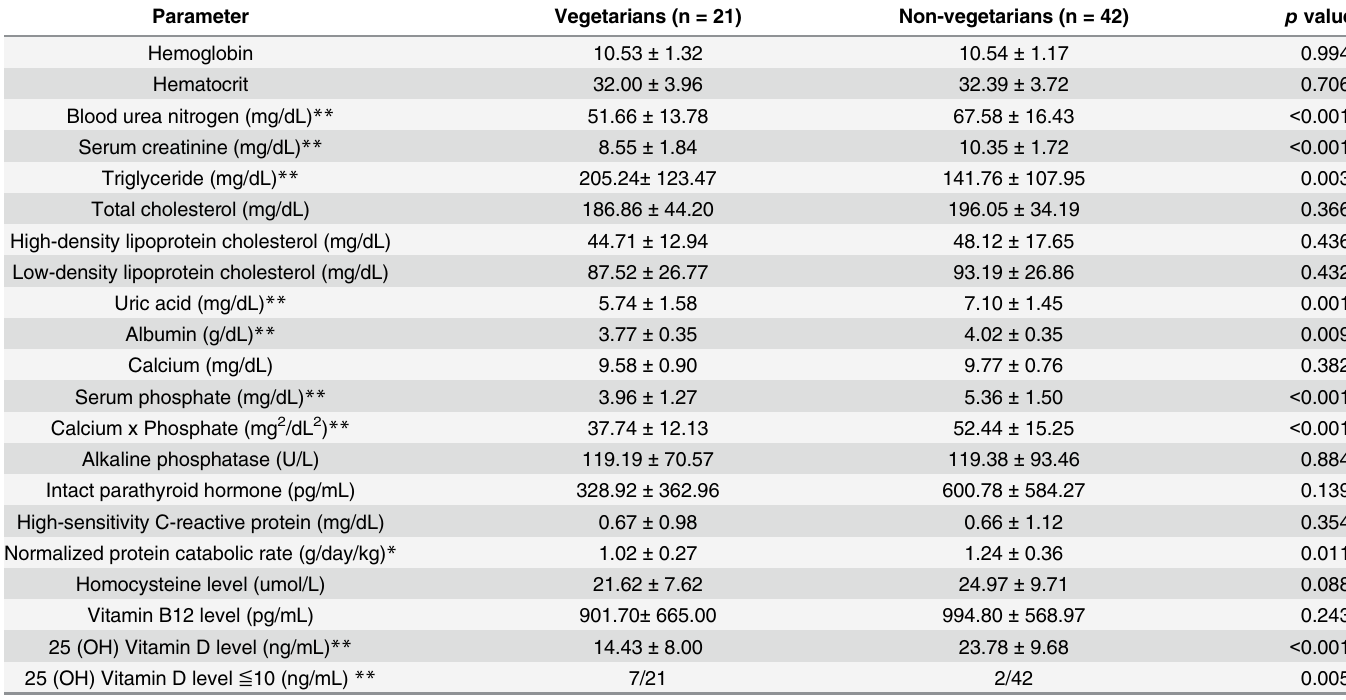
Table 2. Differences in biochemical and nutritional markers between the vegetarian and non-vegetarian